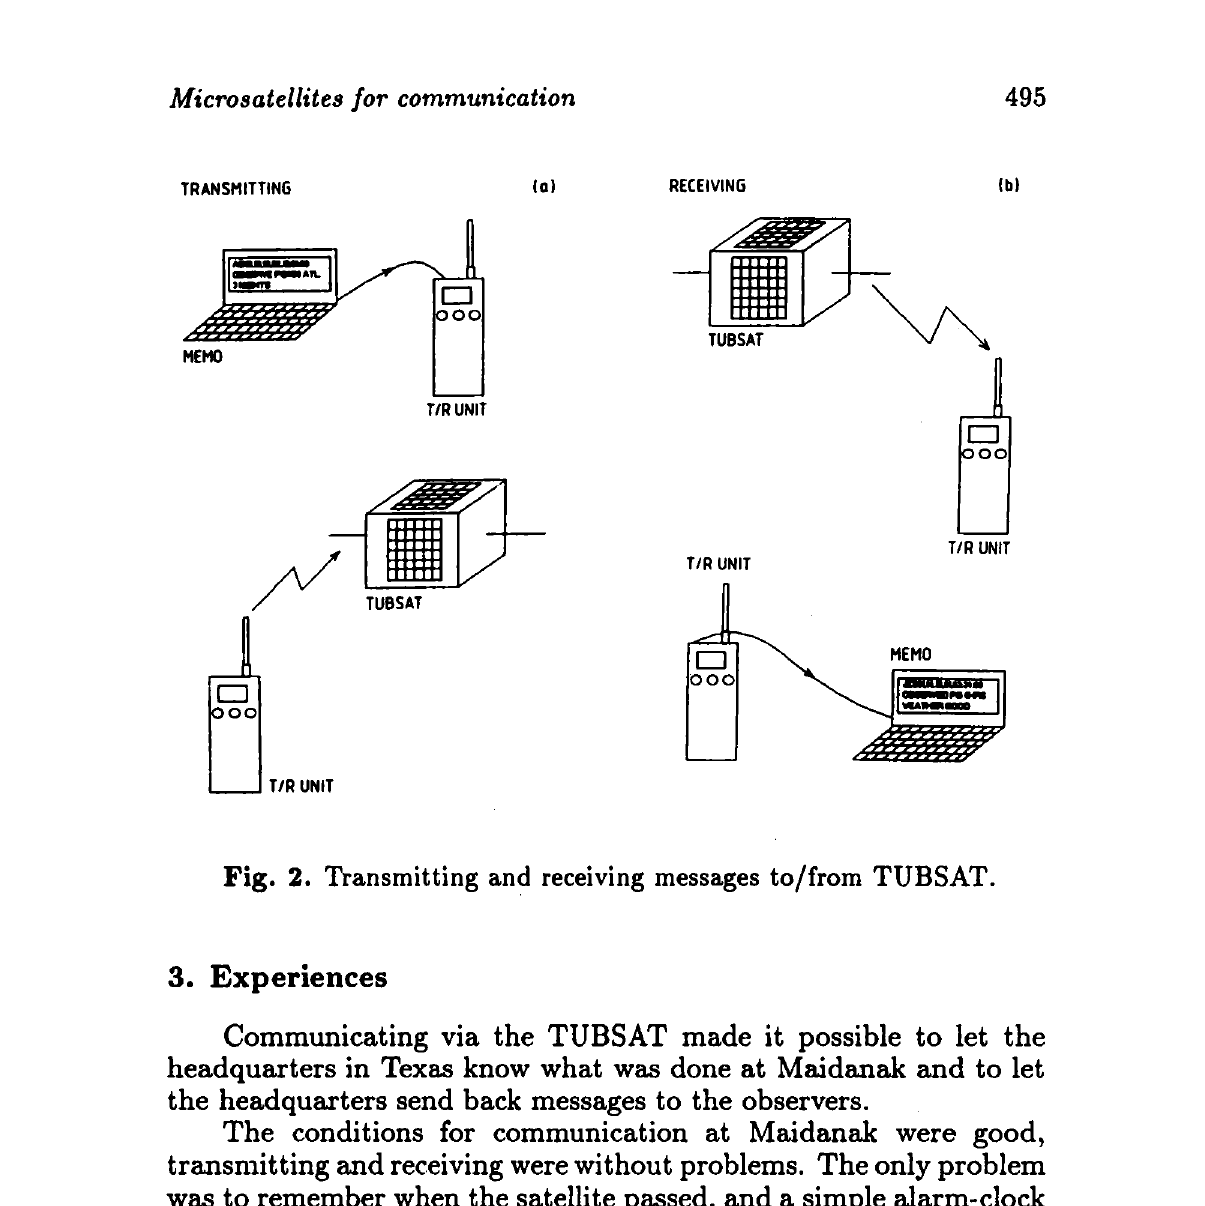
Fig. 2. Transmitting and receiving messages to/from